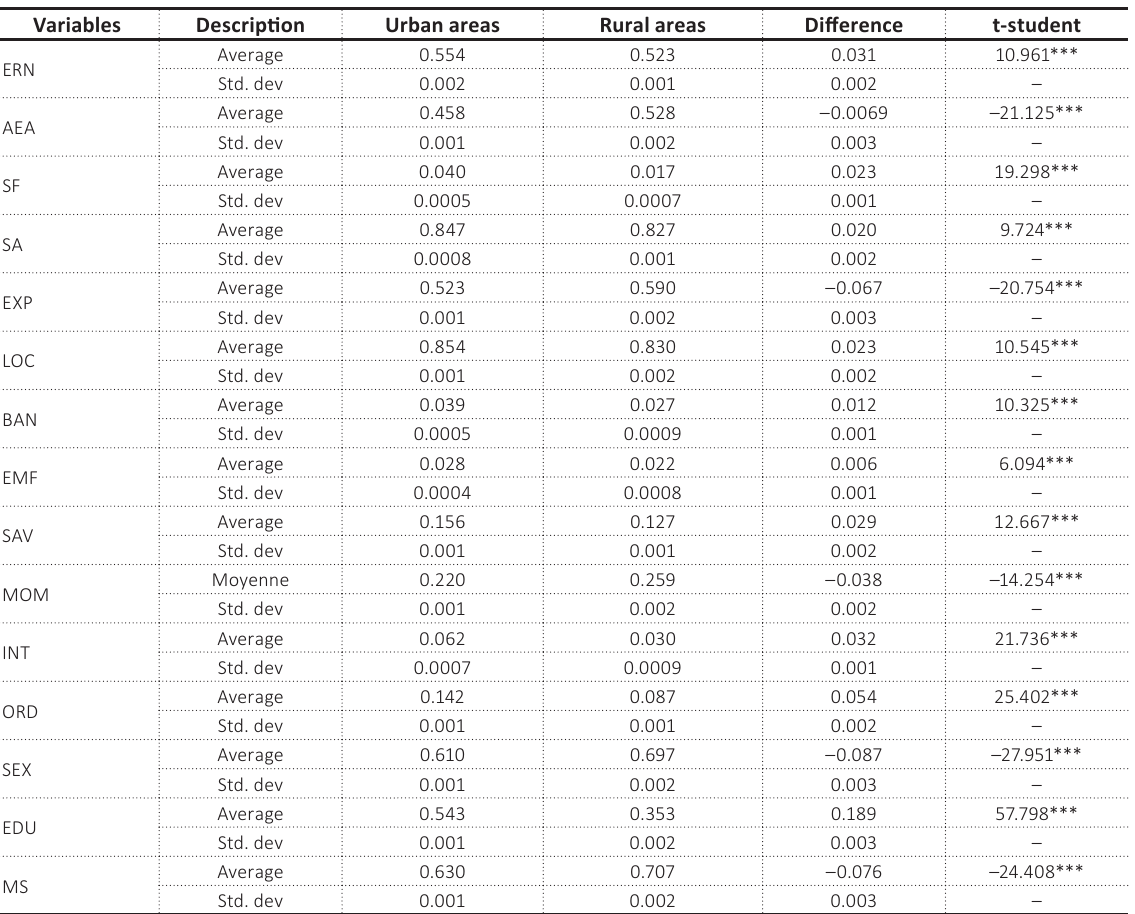
Table 2. Tests for comparison of